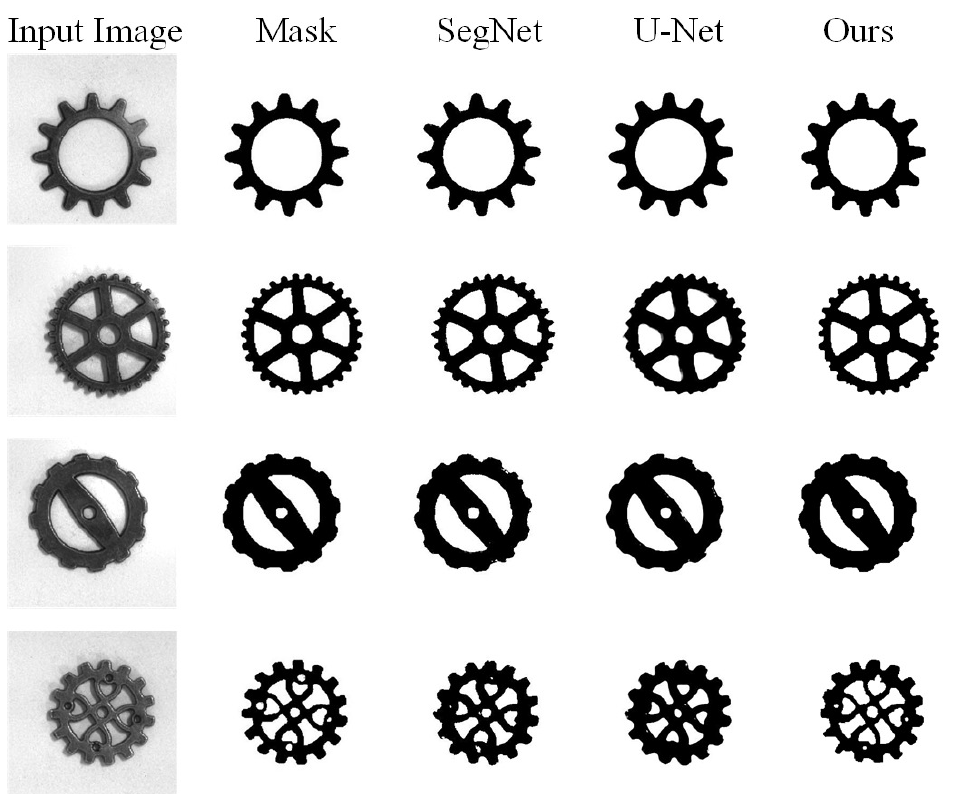
Figure 6. Comparison of different